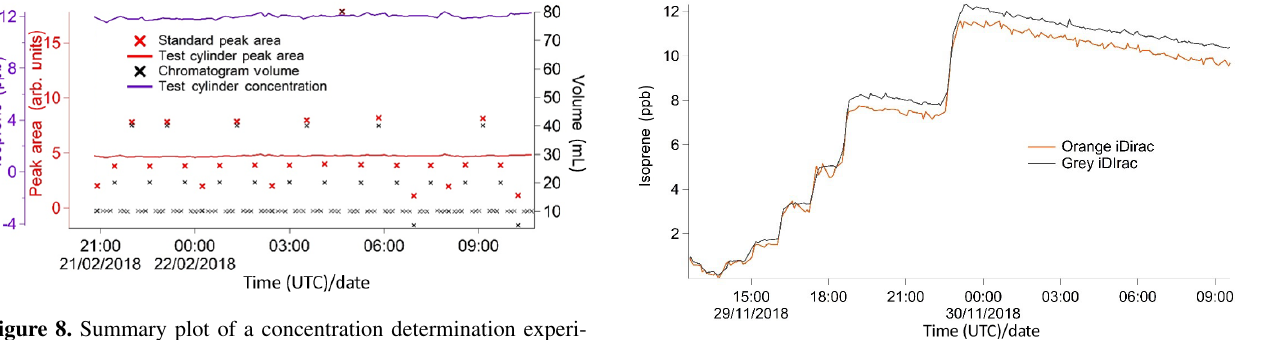
Figure 9. Time series plot showing isoprene mixing ratios from the grey and orange iDirac